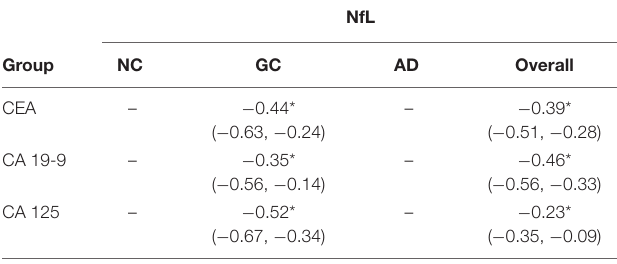
TABLE 2 | Correlations between plasma NfL levels and serum tumor marker